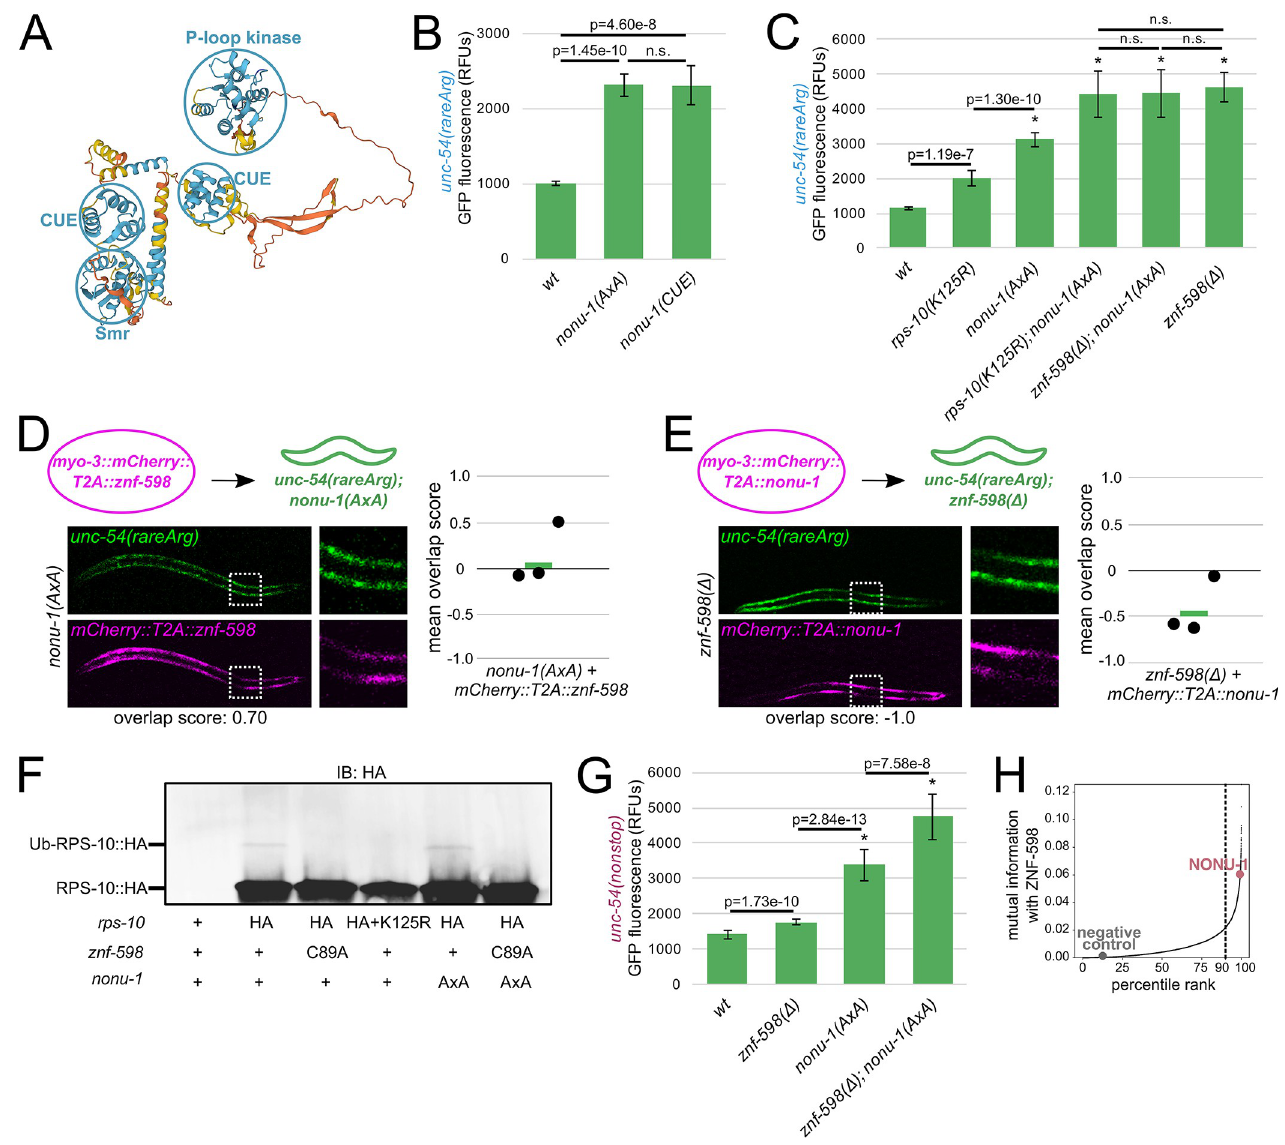
Fig 5. NONU-1 function during NGD requires CUE domains and follows ZNF-598. (A) C . elegans NONU-1 protein structure as predicted by AlphaFold [29]. Prediction confidence is as follows: blue regions are confident, yellow regions are low confidence, orange regions are very low confidence. Confident domains are circled in blue and labeled. (B, C) Mean RFUs (relative fluorescence units) of indicated strains (n � 15 animals/strain) in the unc-54(rareArg) background. One standard deviation shown as error bars. p values from Welch’s t-test, with asterisks indicating p < 0.01 for all comparisons with wild type. (D) As in Fig 2, with znf-598 construct in nonu-1 strain. (E) As in Fig 2, with nonu-1 construct in znf-598 strain. (F) Western blot of indicated strains to monitor ubiquitination of HA-tagged RPS-10. (G) Mean RFUs (relative fluorescence units) of indicated strains (n � 15 animals/strain) in the unc-54(nonstop) background. One standard deviation shown as error bars. p values from Welch’s t-test, with asterisks indicating p < 0.01 for all comparisons with wild type. (H) ZNF-598 mutual information plot. 90% percentile cutoff is shown as a dashed line, NONU-1 is highlighted in pink, and a negative control protein is highlighted in